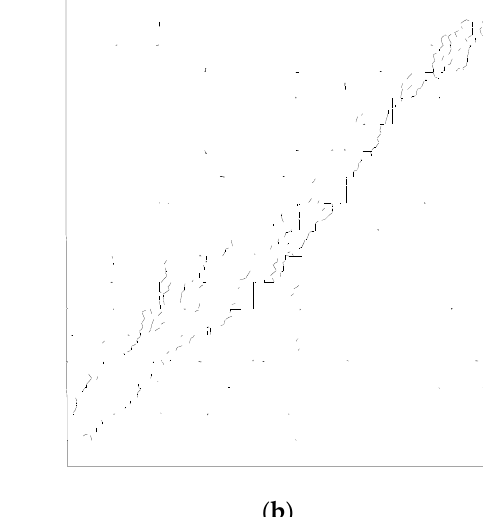
Figure 18. Shear panel model. Horizontal force vs. horizontal displacement.